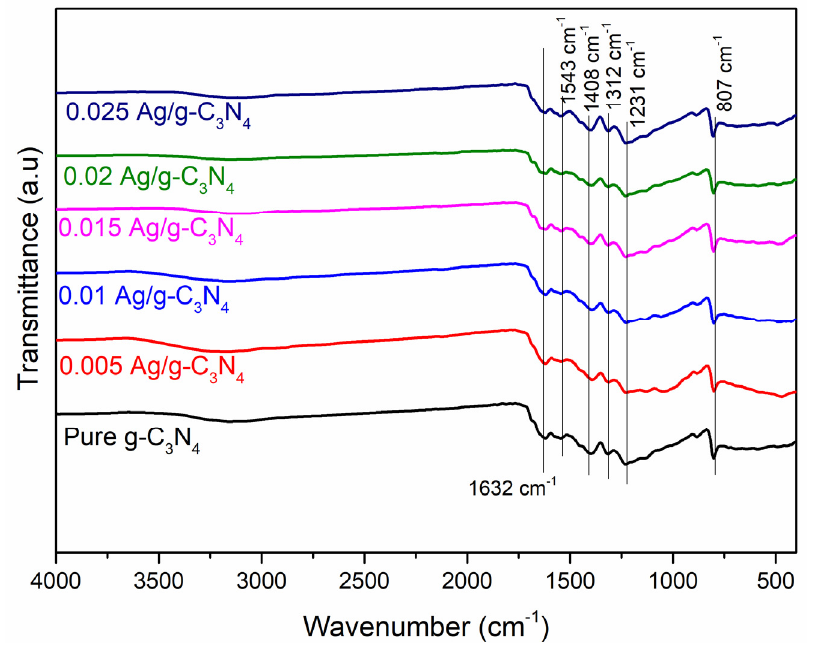
Figure 3. Fourier transform infrared spectra of g-C 3 N 4 and Ag-loaded g-C 3 N 4 structures.